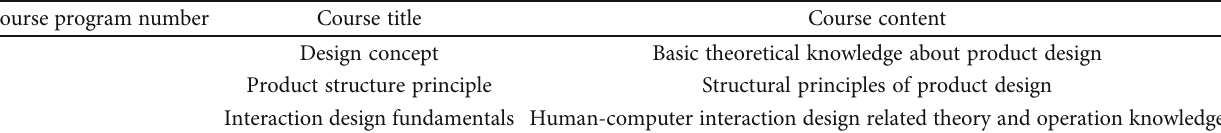
Figure 4: Intelligent network teaching system. Table 2: Contents of intelligent online teaching for product design